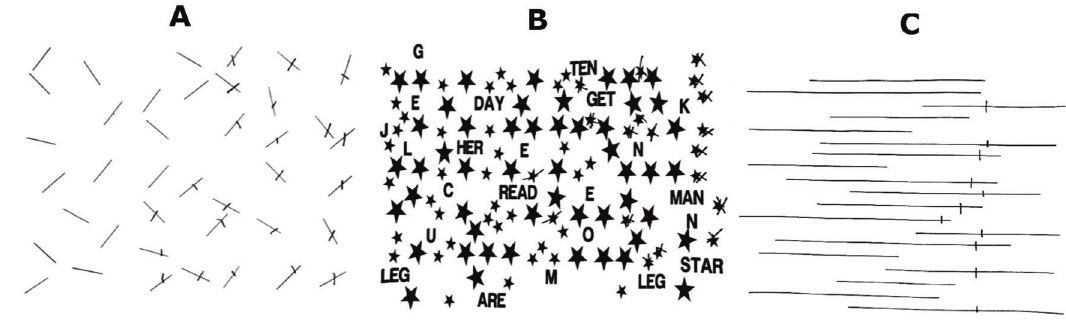
Figure 1 - Clinical use of the three standardized neglect tests in a patient with USN (A) omission of the lines on the left side in LC; (C) omission of the smalls stars on the left side in SC; (C) right deviation of midline in LB.